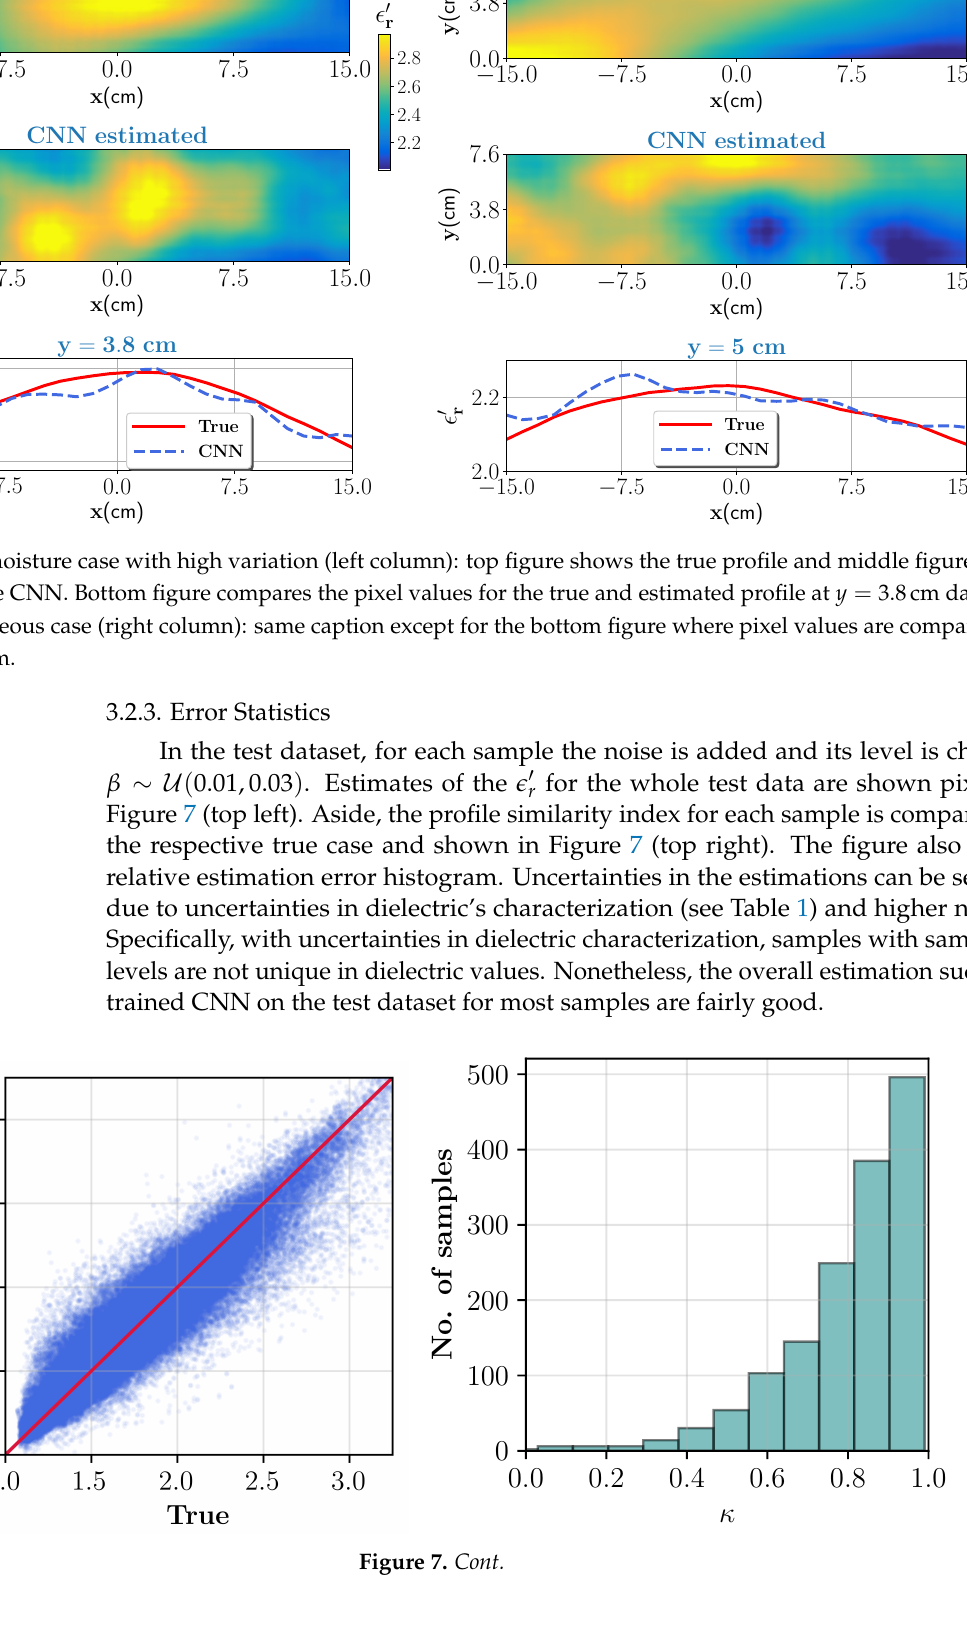
Figure 7. Top left : estimated pixel values of the e 0 r ( x , y ) for the test dataset with 1000 samples. Top right : histogram of factor κ . Bottom : difference between the estimated and true values (relative estimation error) of the real part of the dielectric constant for the total number of test samples. 4. Experimental Setup and Result In this section, the trained CNN performance is tested on the data from our developed MWT experimental prototype. The MWT experimental prototype consist of 7 WR90 open- ended waveguide antennas and placed over the foam of width = 50 cm, height = 7.6 cm, and length = 75 cm, respectively. The distance of the antenna to the top surface of the polymer foam is 5 cm, and the center to center distance between two adjacent antennas is 5 cm. Antennas are fixed and placed in free-space from − 15 cm to 15 cm along the x- axis. For data acquisition, antennas are connected to the Agilent N5224A vector network analyzer (VNA) via a P9164C 2 × 16 USB Solid state switch matrix. Phase stable cables (with phase stability of 3 ◦ at maximum frequency) are used for the connection. Communication between the VNA, switch, and the controlling computer is accomplished through the Ethernet cable. The block diagram of the data acquisition scheme and the S 11 (return- loss) response of a WR-90 waveguide antenna are shown in Figure 8 top left and top right, respectively. The data acquisition process and image reconstruction process (<1 s) is entirely automated using MATLAB. The measured scattered electric field data, in terms of scattering parameter, is acquired at 8.3 GHz frequency at cross-section of z = 0 cm and takes around 20 s. Since the CNN network is trained on electric field data instead of scattering parameter, calibration scheme in [56] is employed for its conversion.